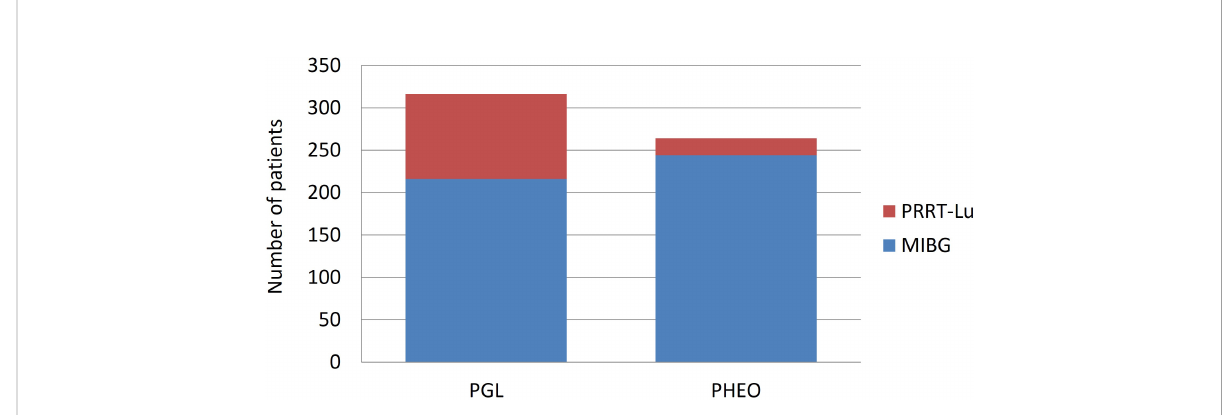
FIGURE 2 Distribution of the administered treatments according to the adrenal or extra-adrenal location of the